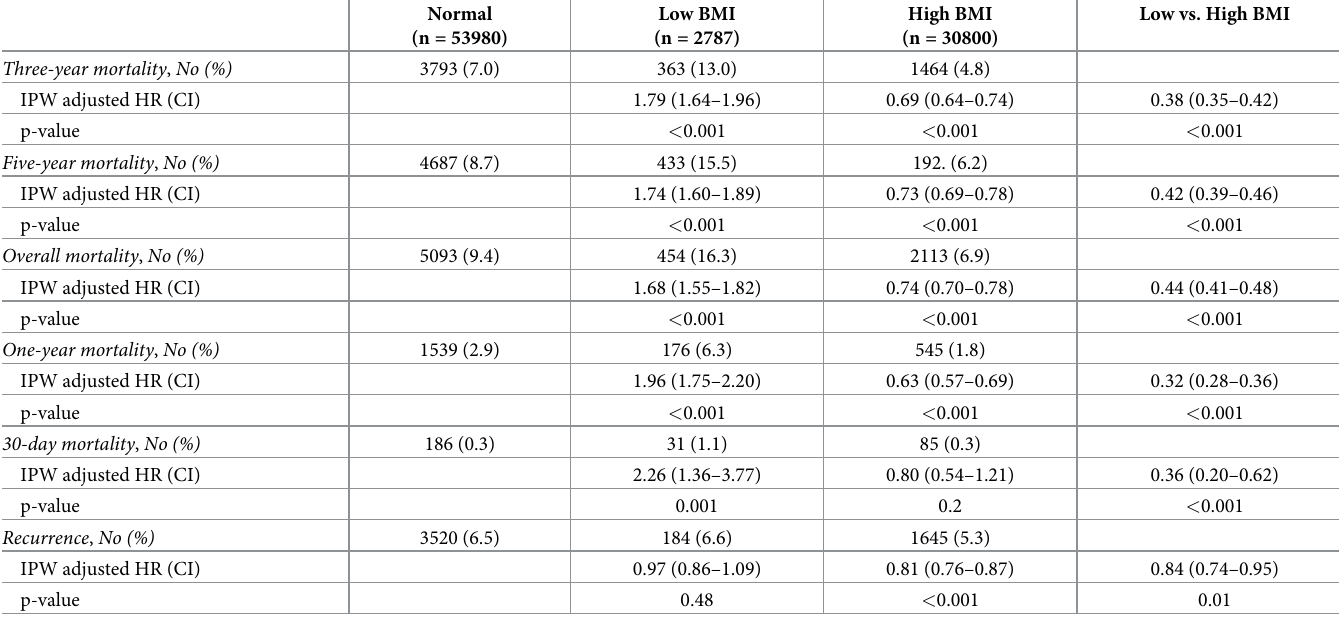
Table 2. Mortalities and recurrence rate according to preoperative body mass